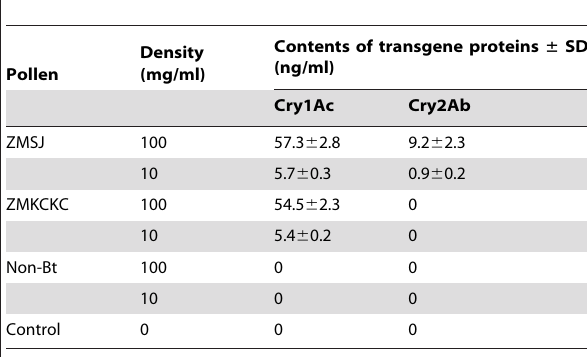
Table 2. Cry1Ac and Cry2Ab protein content in different food types of the silkworm Bombyx